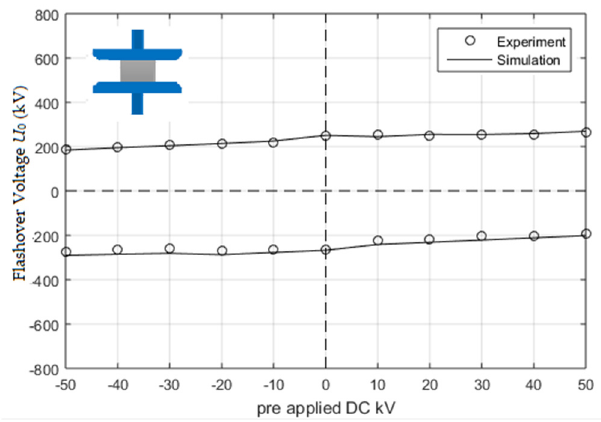
Figure 8. Breakdown characteristics of superimposed flashover voltages without particle contami- nation (Case 2), D = 15 mm, P = 0.4 MPa, ε r = 5.93.